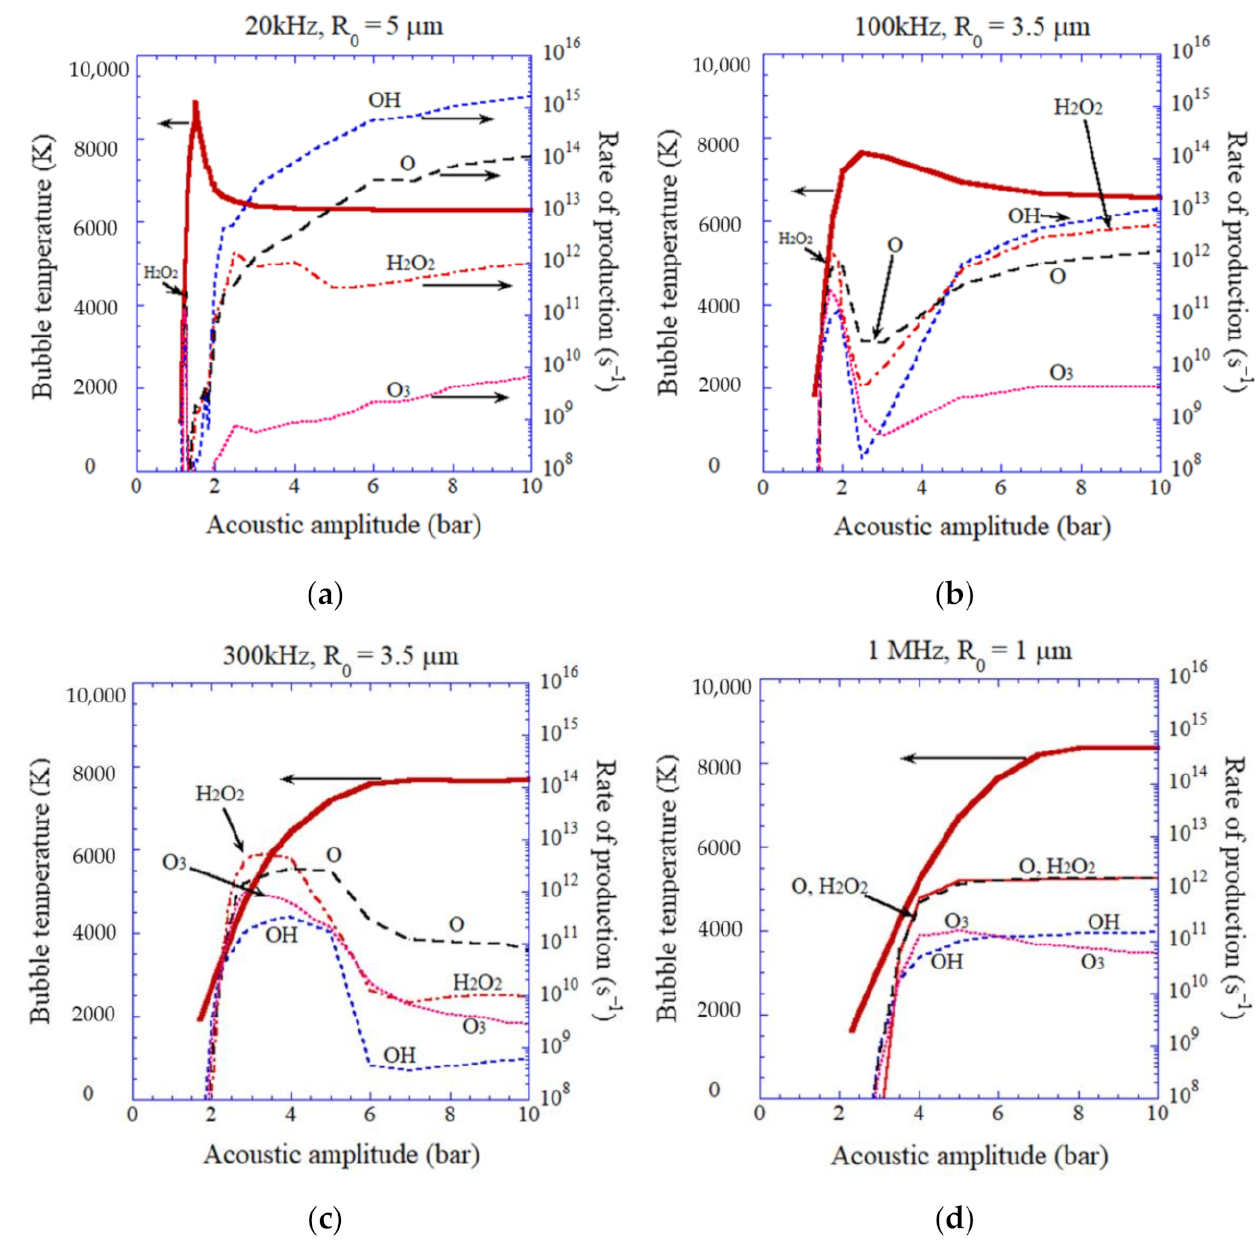
Figure 6. The results of the numerical simulations on the rate of production of each oxidant inside an isolated air bubble calculated by the first bubble collapse as a function of acoustic amplitude as well as the temperature inside a bubble at the end of the bubble collapse (the red thick line)